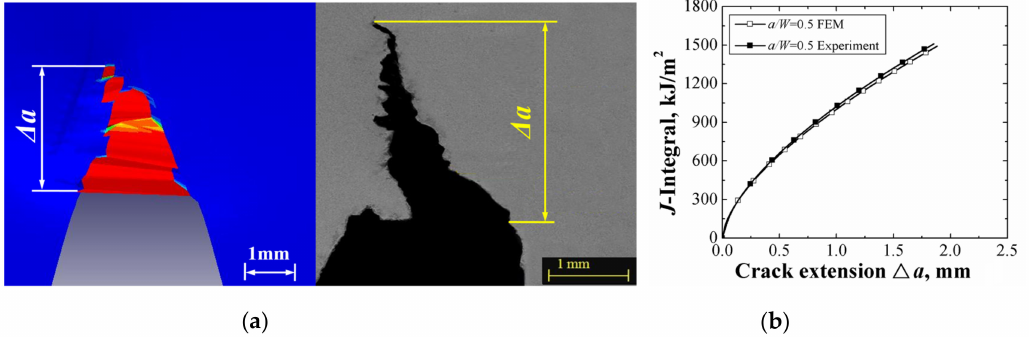
Figure 6. The comparison of finite element results obtained by the Gurson–Tvergaard–Needleman (GTN) damage model with experimental results: ( a ) crack propagation paths; ( b ) J -resistance